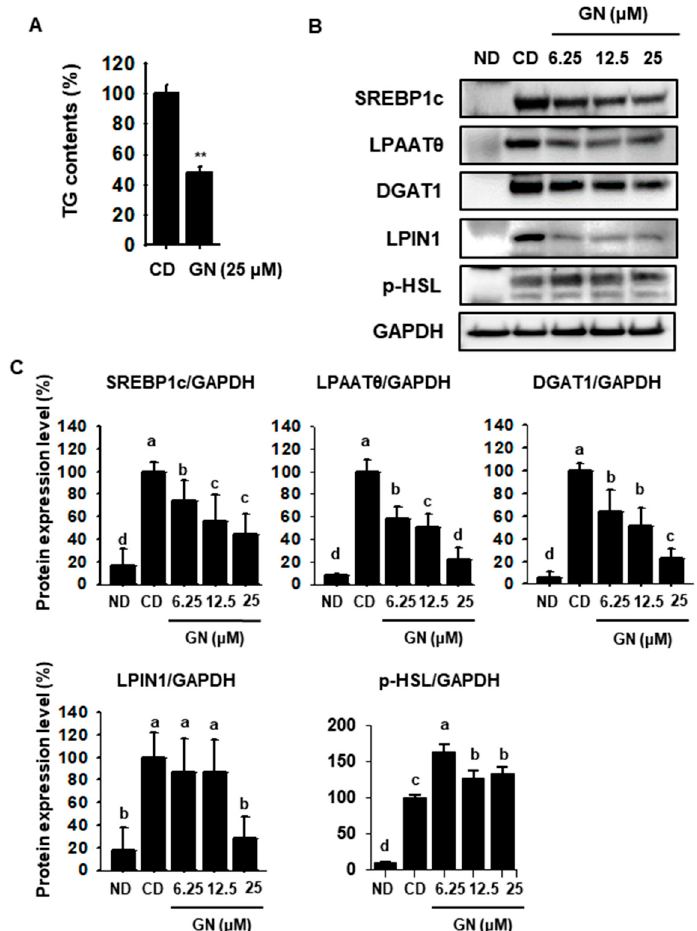
Figure 2. Effects of GN on triglyceride synthesis in 3T3-L1 cells. ( A ) Intracellular triglycerides (TGs) in 3T3-L1 cells treated with GN were measured using a TG ELISA kit. ( B , C ) Western blotting for the lipogenesis factors sterol regulatory element-binding transcription factor 1c (SREBP1c), lysophosphatidic acid acyltransferase theta (LPAAT θ ), diacylglycerol acyltransferase 1 (DGAT1), phosphatidate phosphatase (LPIN1) and phosphorylated hormone sensitive lipase (p-HSL) in 3T3-L1 cells and quantification of band density. Protein data are expressed as mean ± SD ( n = 4). Values with different letters are significantly different, p < 0.05 (a > b > c > d).